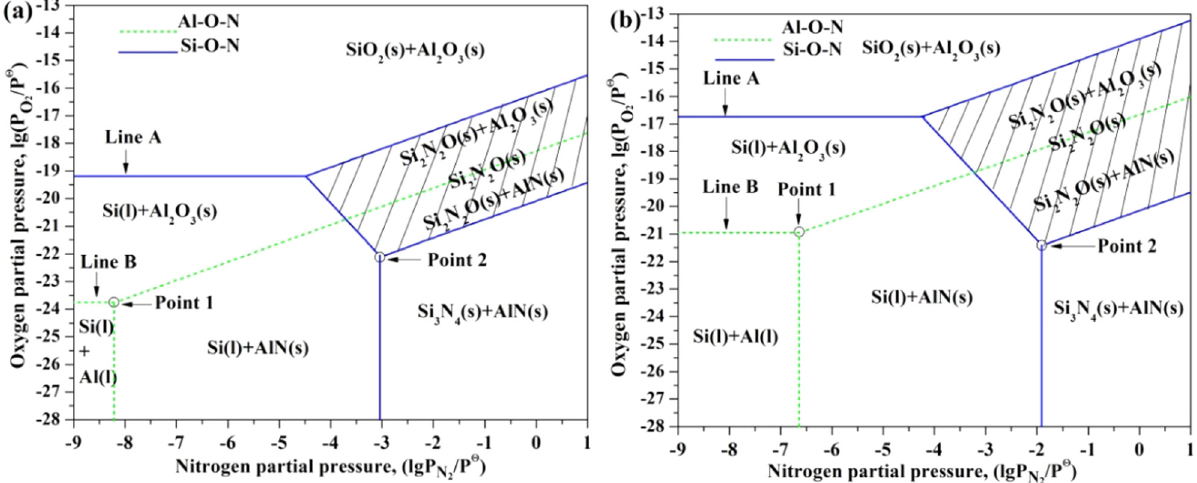
Figure 2: Overlapped phase stability diagram of Si – O – N and Al – O – N systems at ( a ) T = 1,673 K and ( b ) T = 1,823 K.